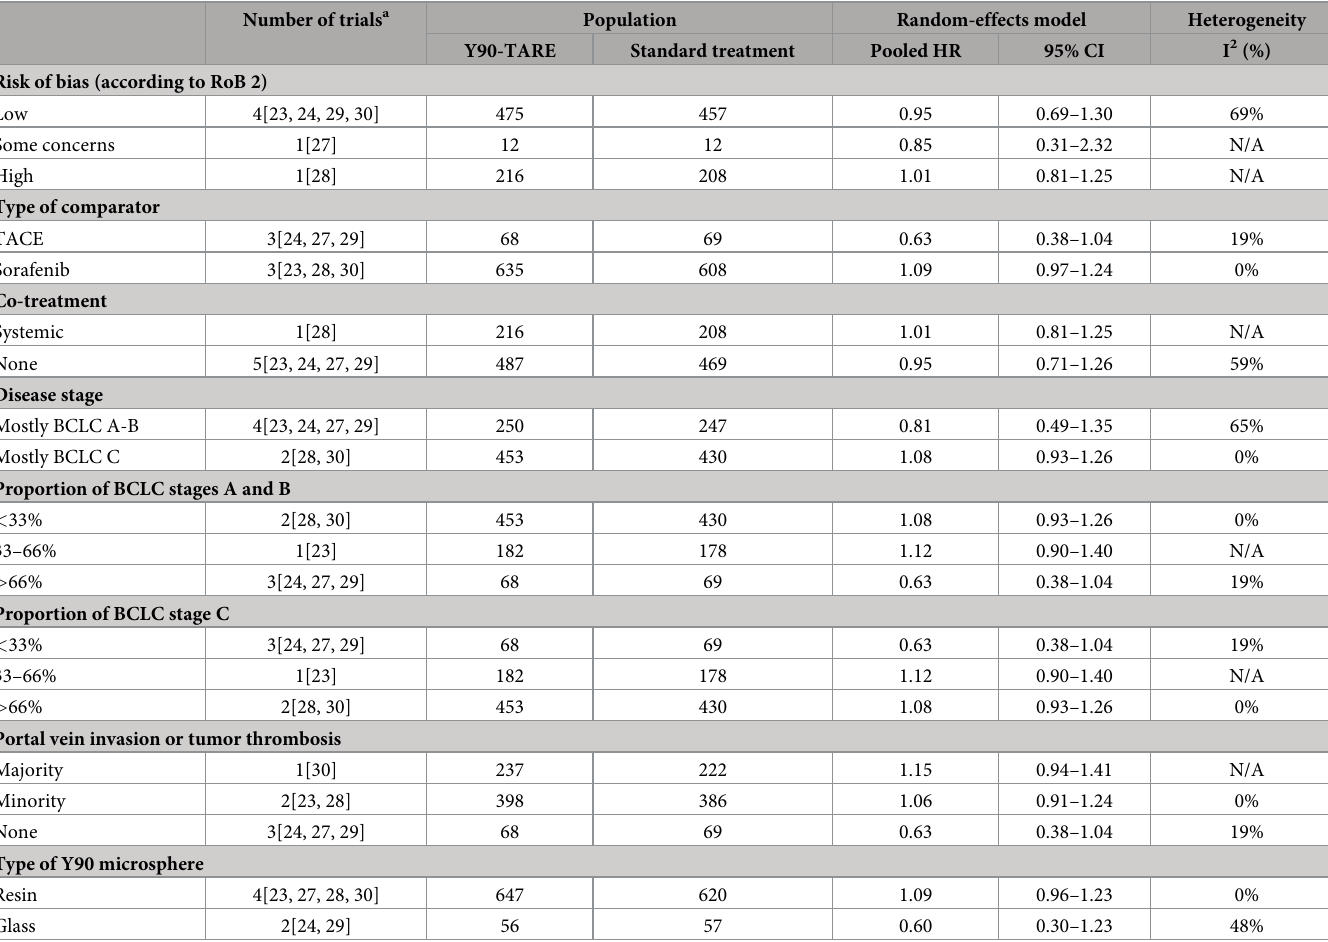
Table 2. Predefined subgroup analyses for the primary